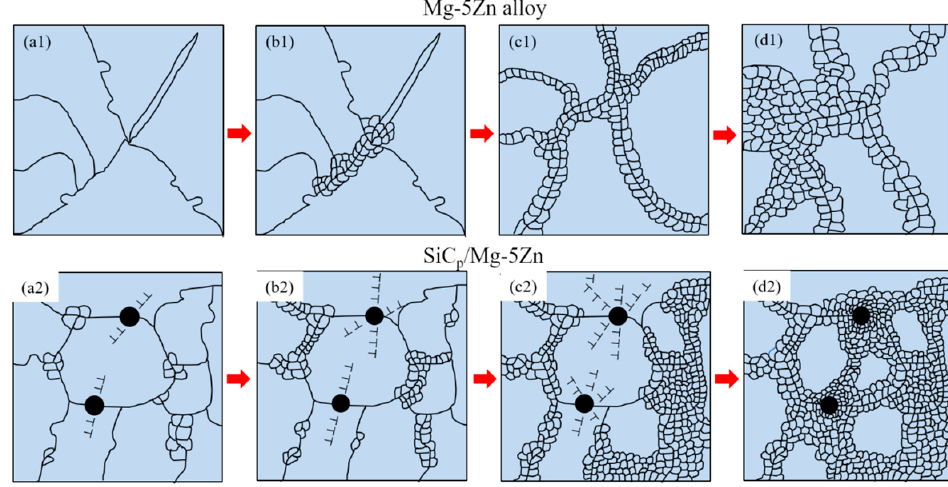
Figure 17. Schematic diagrams of DRX for the Mg-5Zn alloy and SiC p /Mg-5Zn material with different compression strains: ( a1 , a2 ) 0.05, ( b1 , b2 ) 0.1, ( c1 , c2 ) 0.35 and ( d1 , d2 ) 0.7.